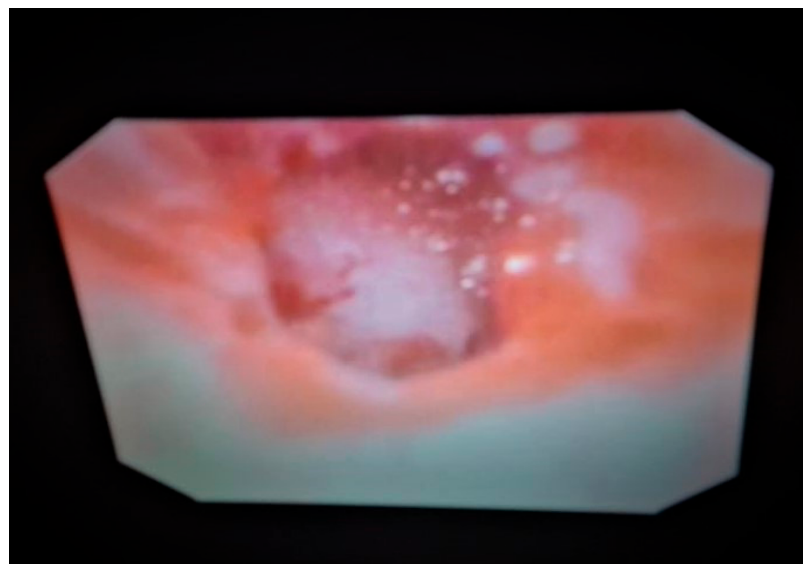
Figure 4. The calyx after the widening of the infundibulum.